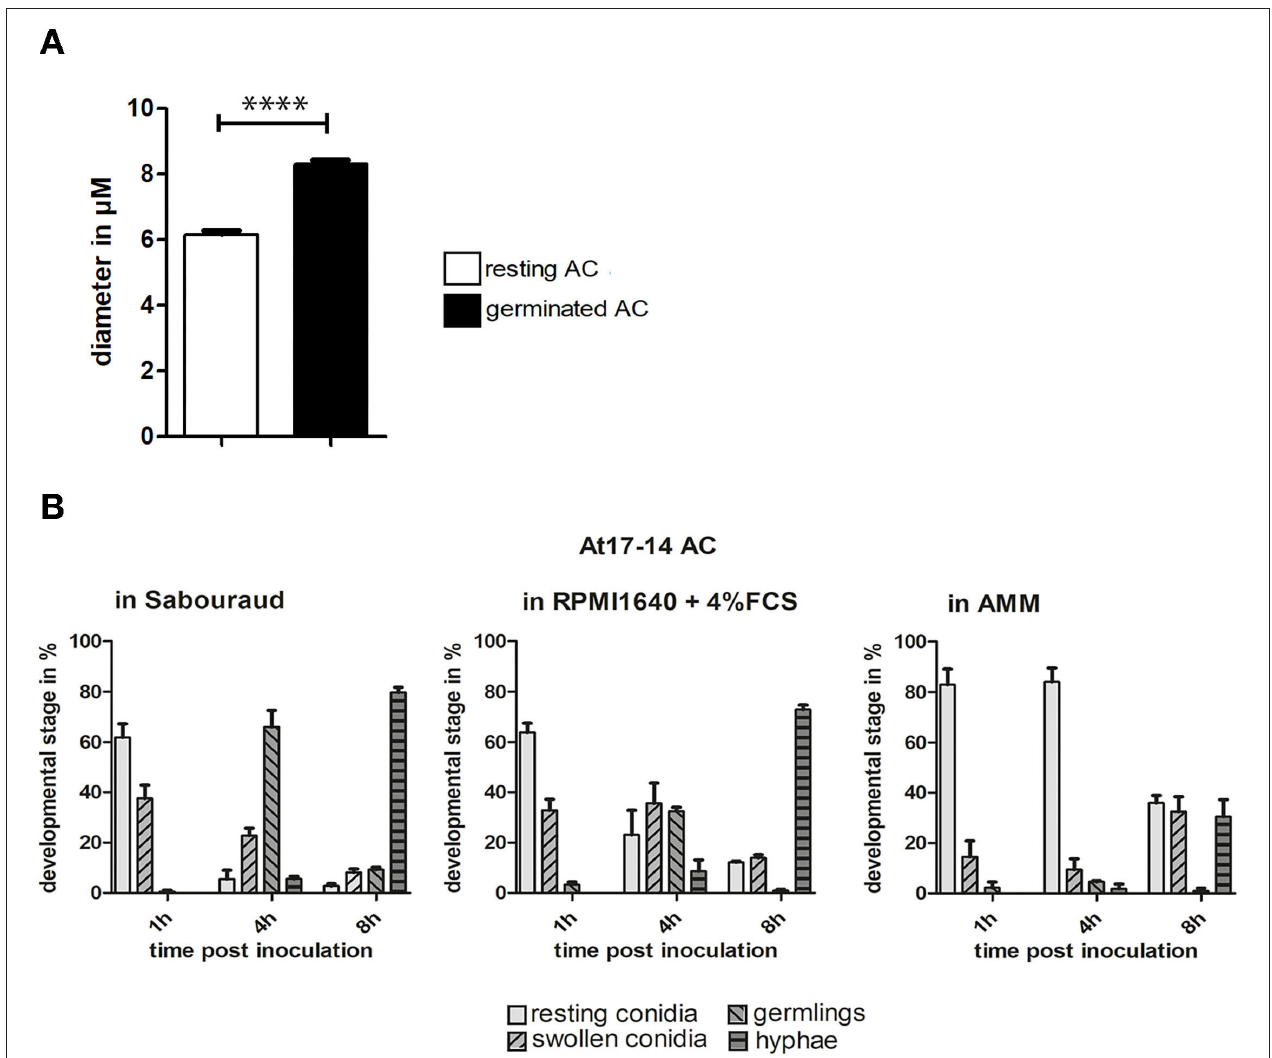
FIGURE 4 | Germination of AC. (A) : the diameters of AC of strain At17-14 were measured for resting conidia and conidial bodies after germination in cell culture medium. Each column represents the values of three groups comprising 50 measurements each; standard deviations are indicated. **** p < 0.0001 according to an unpaired Student’s t -test. (B) shows a quantitative analysis of the germination process over time for AC of strain At17-14 in three different media (AMM, Sabouraud, and RPMI1640 + 5% FCS). Each column represents the values of three groups each comprising 60 events. Standard deviations are